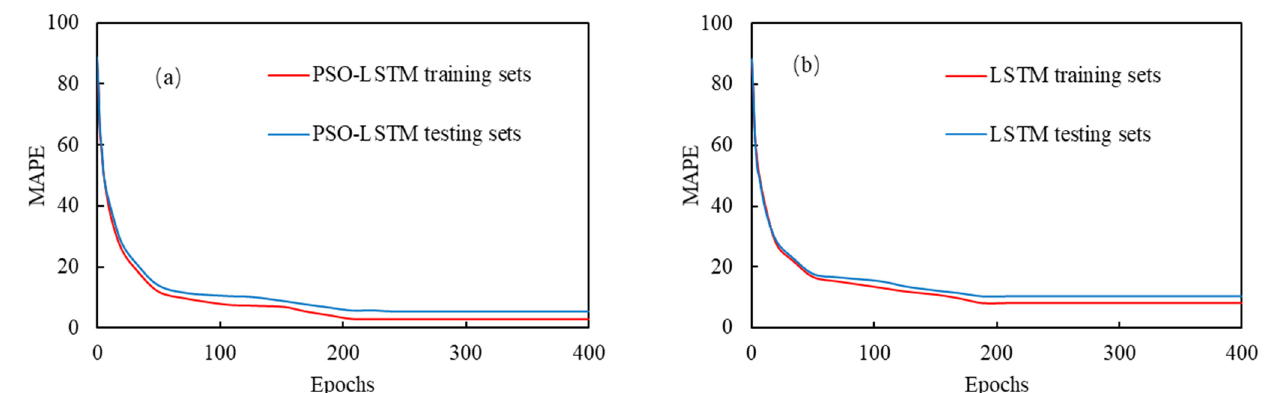
Figure 7. Comparisons of loss decline curve of LM and PA-LM model: ( a ) the training processes; ( b ) the testing processes.